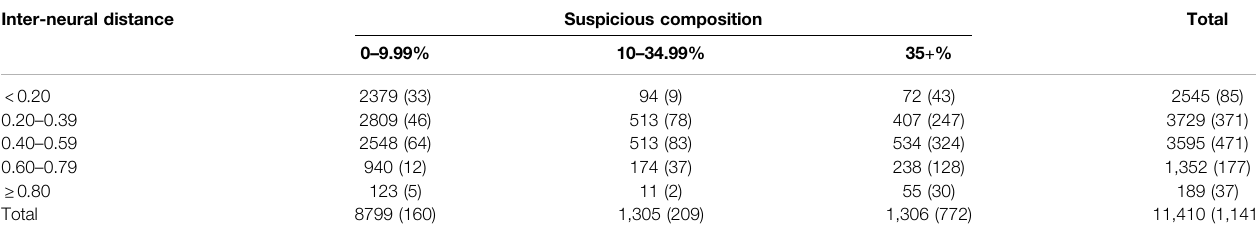
TABLE 5 | The distribution of test accounts along the risk categorisation matrix. Notation of the numbers is: all accounts (suspicious accounts).